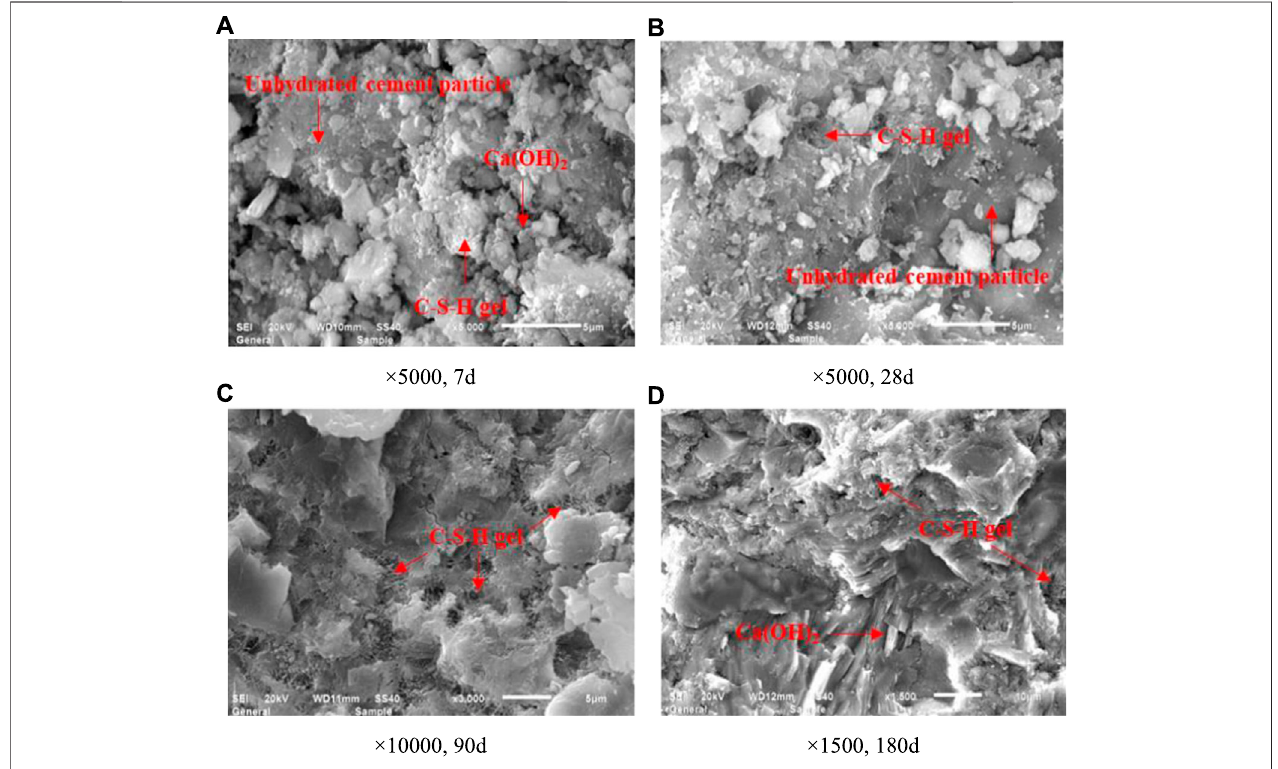
FIGURE 9 | SEM images of hardened paste of NH1 (0% Tuff